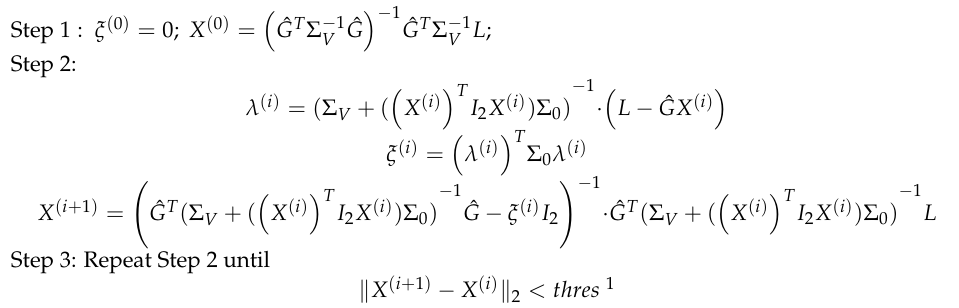
Table 2. Equations of iterative total least squares estimation presented in